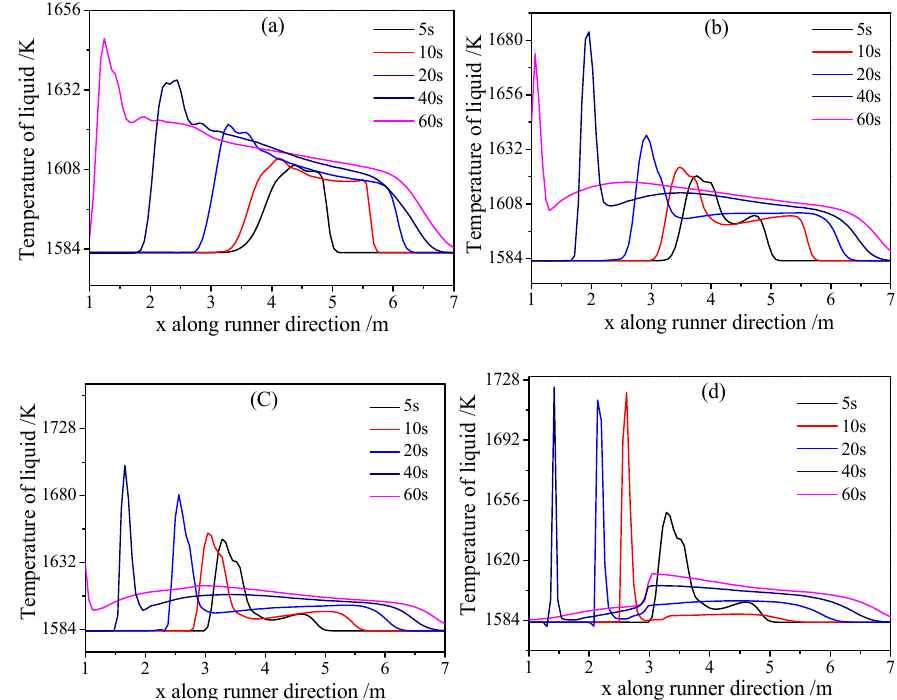
Figure 10. Temperature fluctuations of four lines during tapping (( a ) line 3, ( b ) line 4, ( c ) line 5 and ( d ) line 6, cf. Figure 3b). Processes 2020 , 8 , x FOR PEER REVIEW